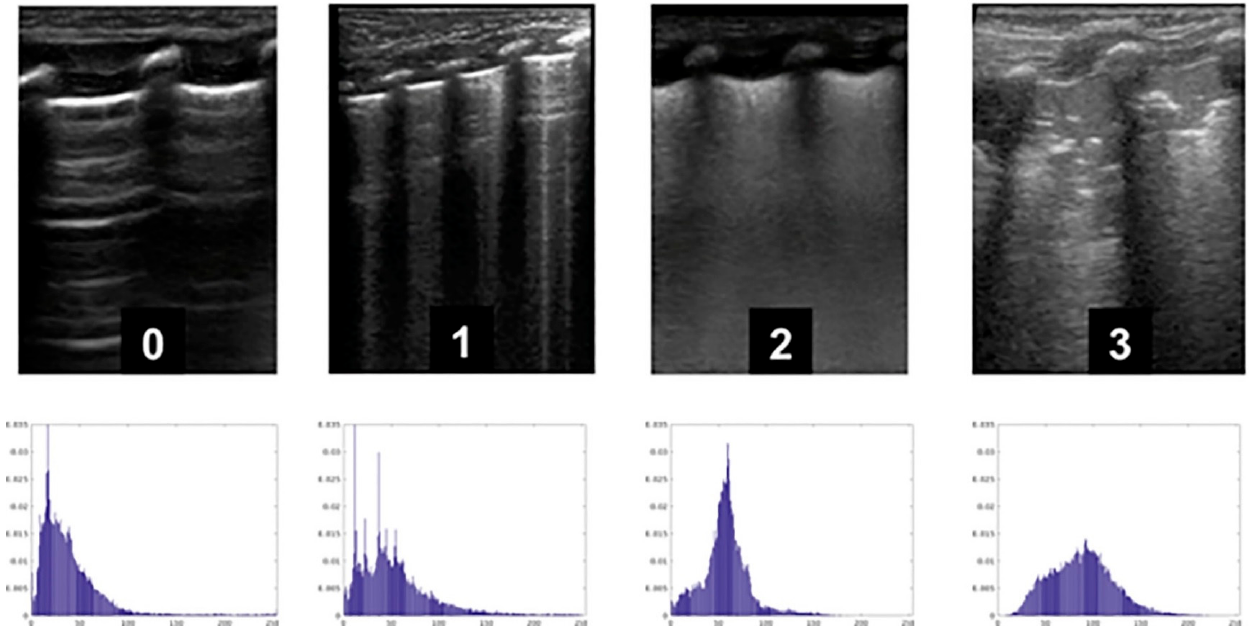
Figure 2. Representative lung ultrasound images used for scoring and calculated histograms (source: [62]).